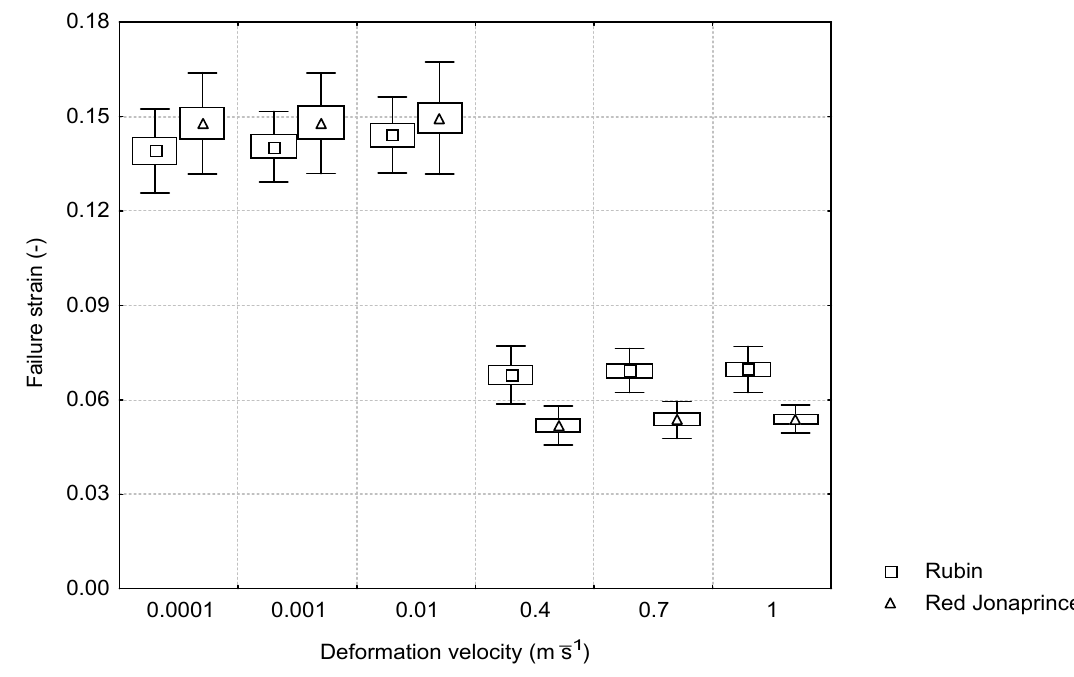
Figure 6. Relationship between the failure strain and the deformation velocity for the two apple cultivars.